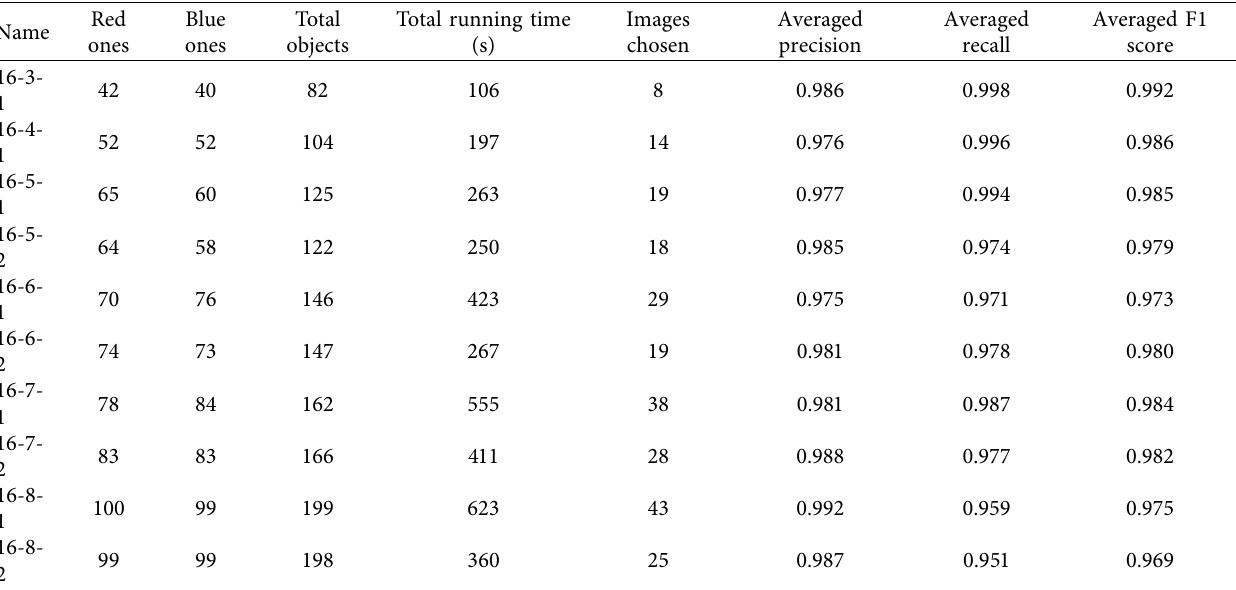
Table 3: The statistics of testing